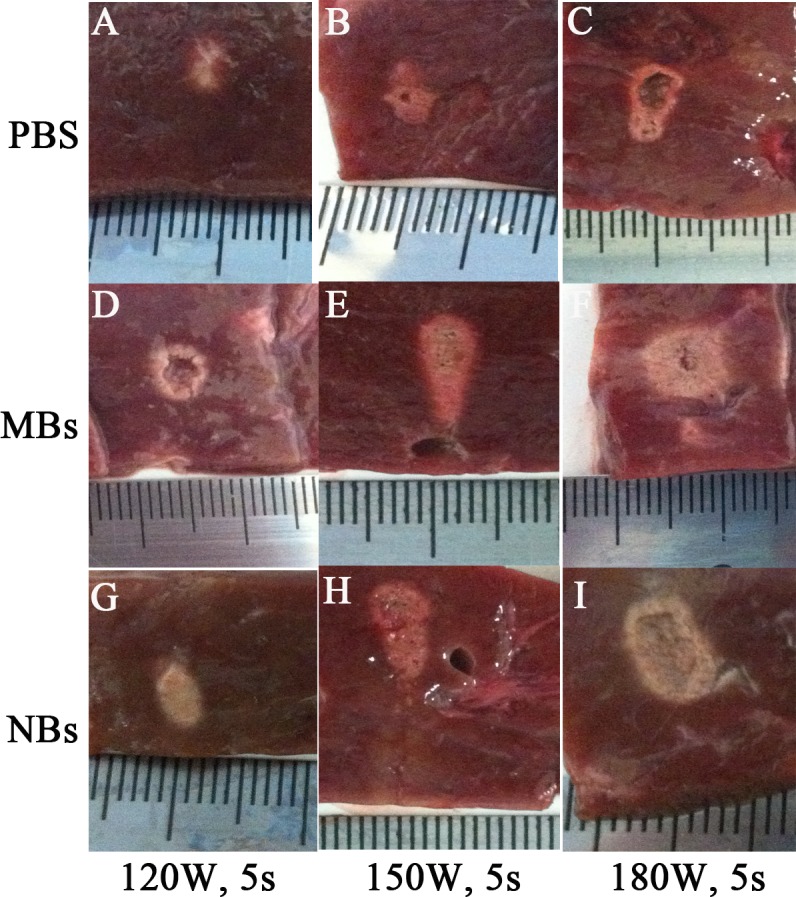
Photography of the targeted area in excised bovine liver after HIFU ablation.After HIFU ablation, the targeted area showed grey white in color. The boundary against the surrounding tissue was sharp and clear.